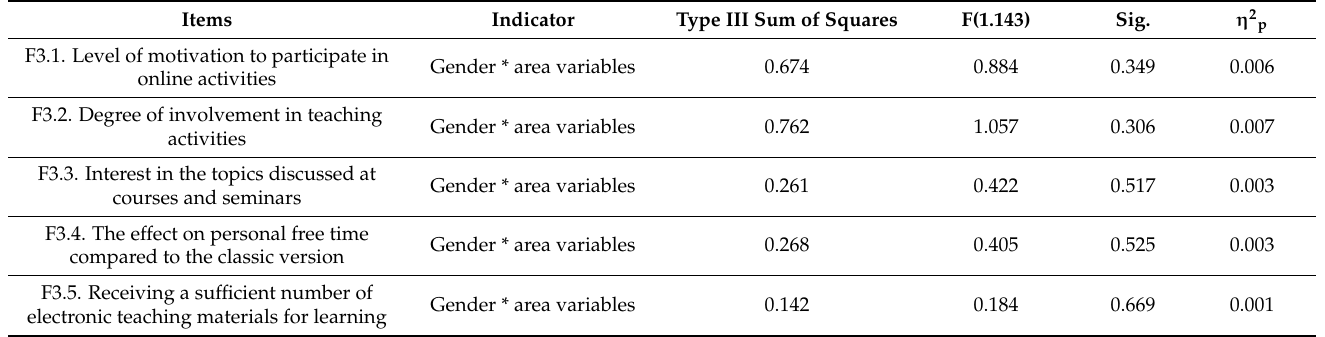
Table 7. Tests of between-subjects’ effects—the cumulative effect of gender variables * area variables on F3 factor